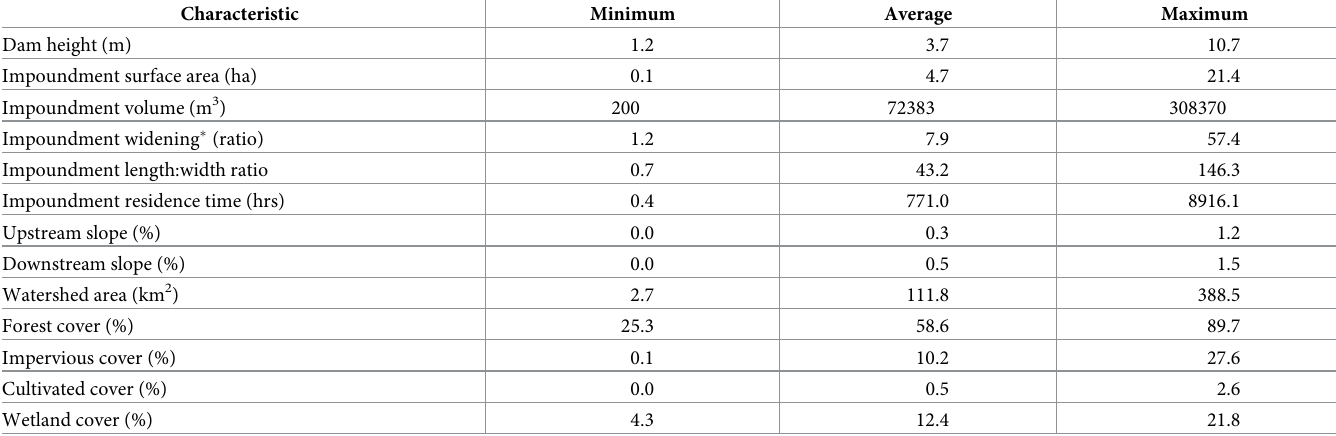
Table 2. Dam, stream, and watershed characteristics for the 15 sites monitored within this